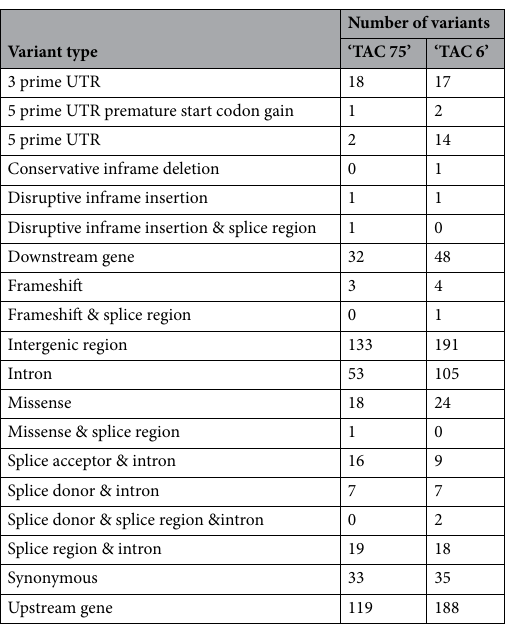
Table 2. Total number of variants identified in different variant types in mutant lines ‘TAC 75’ and ‘TAC